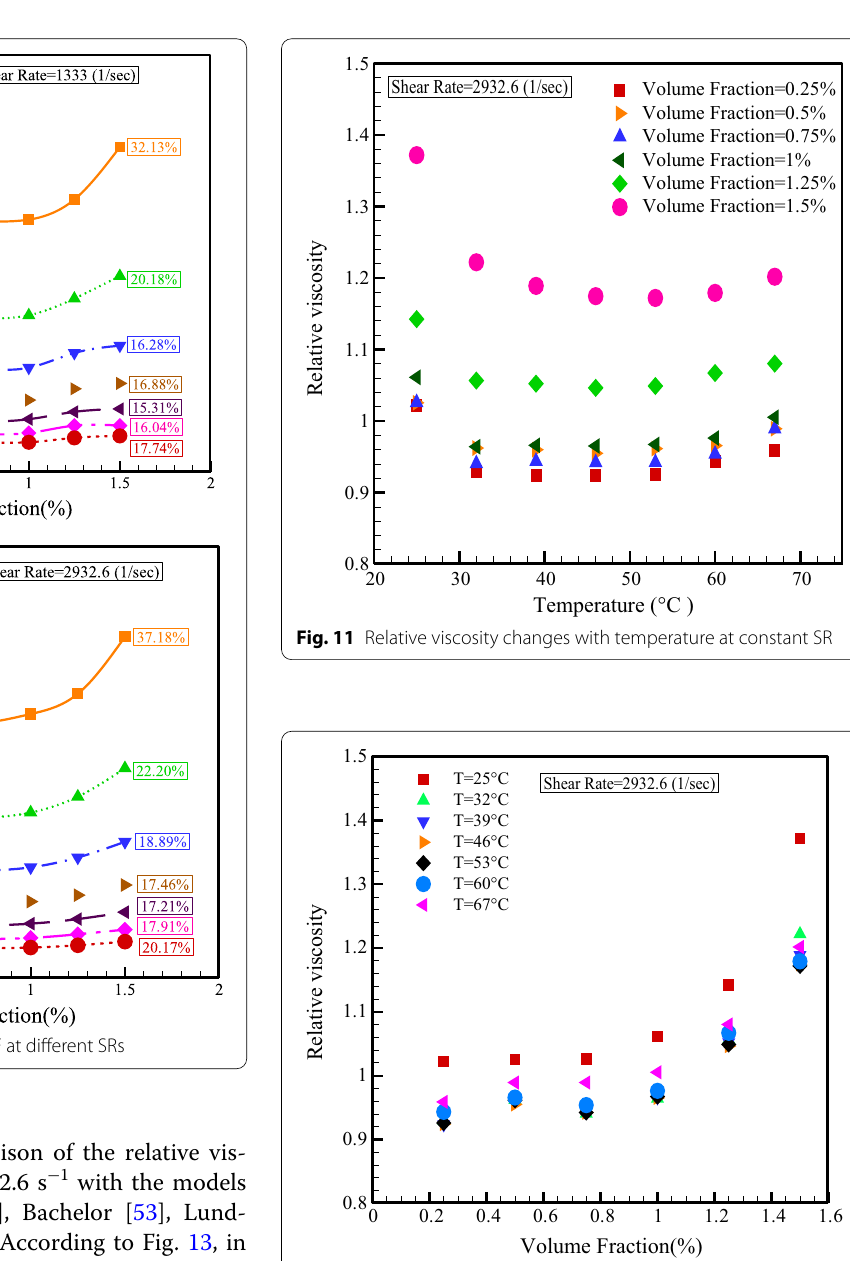
Fig. 12 Relative viscosity change in terms of NPSVF at constant